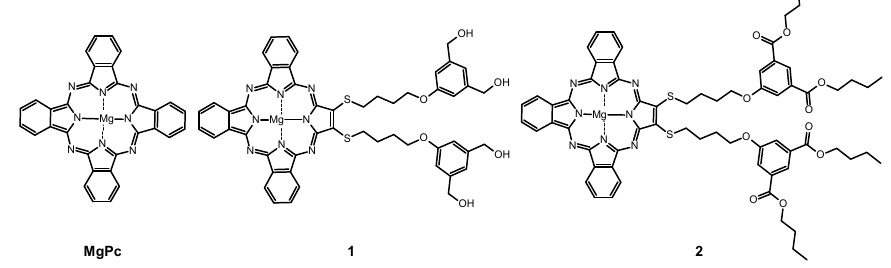
Figure 1. Chemical structures of studied macrocycles: MgPc, 1, and 2.